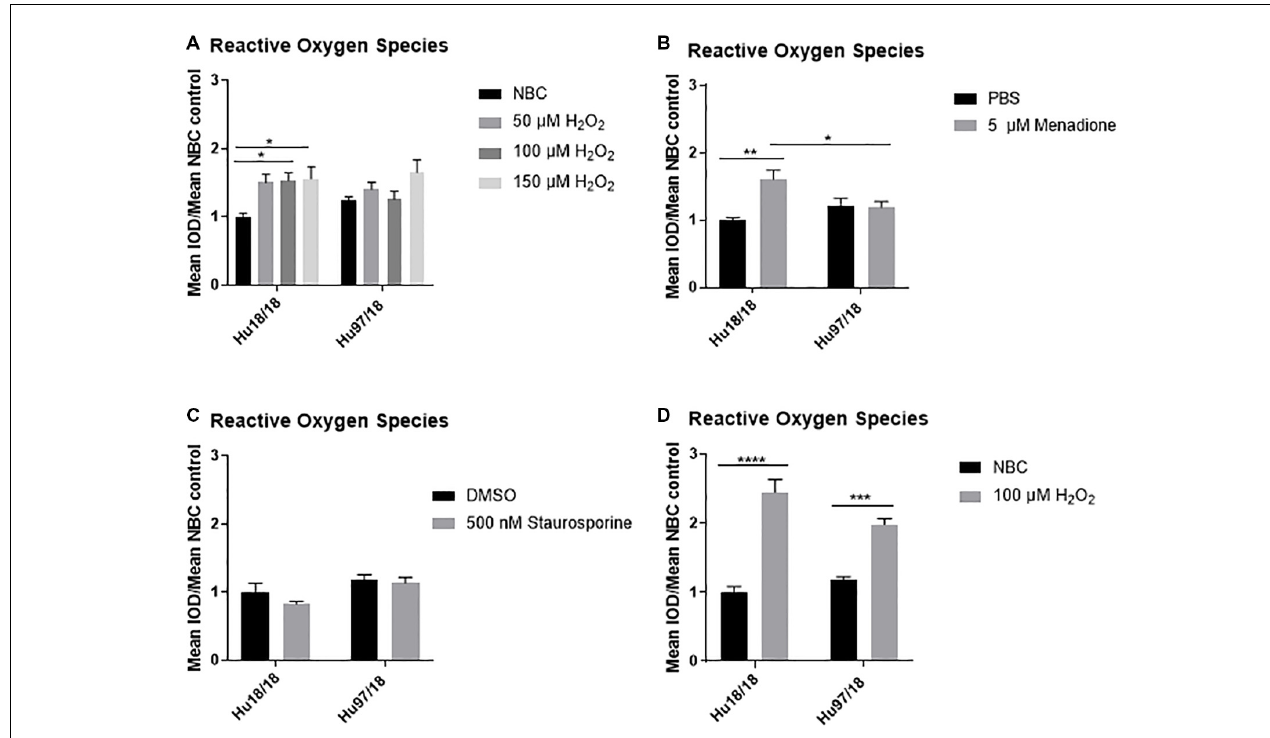
FIGURE 1 | Oxidative stressors increase reactive oxygen species (ROS) in immature control and mature Huntington’s Disease (HD) primary neurons. Primary Hu97/18 and Hu18/18 control neurons were treated with stressors for 24 h and ROS was measured by live-imaging of CM-H2DCFDA fluorescence. Immature neurons were treated with (A) neurobasal complete (NBC) or H 2 O 2 at the indicated doses. (B) PBS or 5 µ M menadione. (C) DMSO or 500 nM staurosporine. (D) Mature neurons were treated with 100 µ M H 2 O 2 . All data were normalized to mean Hu18/18 vehicle control. *Difference between indicated bars, * p < 0.05, ** p < 0.01, *** p < 0.001, **** p < 0.0001. Error bars ±